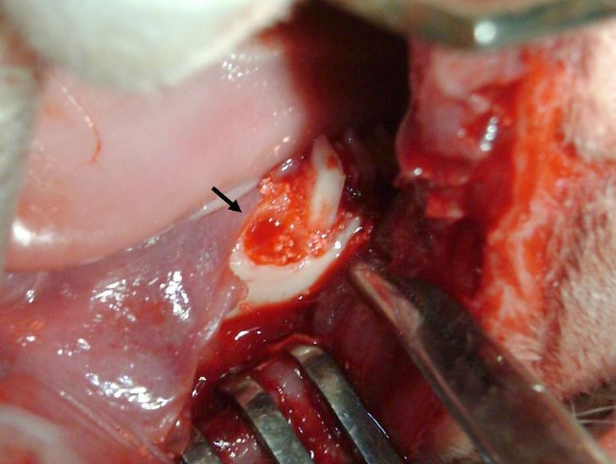
FIGURE 4 – Implantation of the bone graft in the tooth